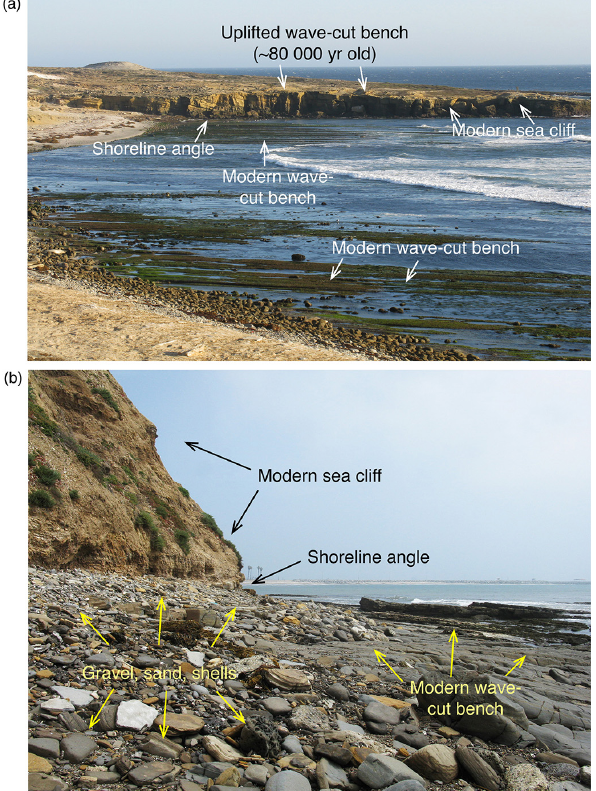
Figure 4. (a) Modern wave-cut bench exposed at low tide, shore- line angle, sea cliff, and wave-cut bench of emergent, ∼ 80ka ma- rine terrace, Cormorant Rock, San Nicolas Island, California, USA. (b) Modern wave-cut bench exposed at low tide, overlying marine gravels, shoreline angle, and sea cliff, San Pedro, California, USA. Photographs by Daniel R.